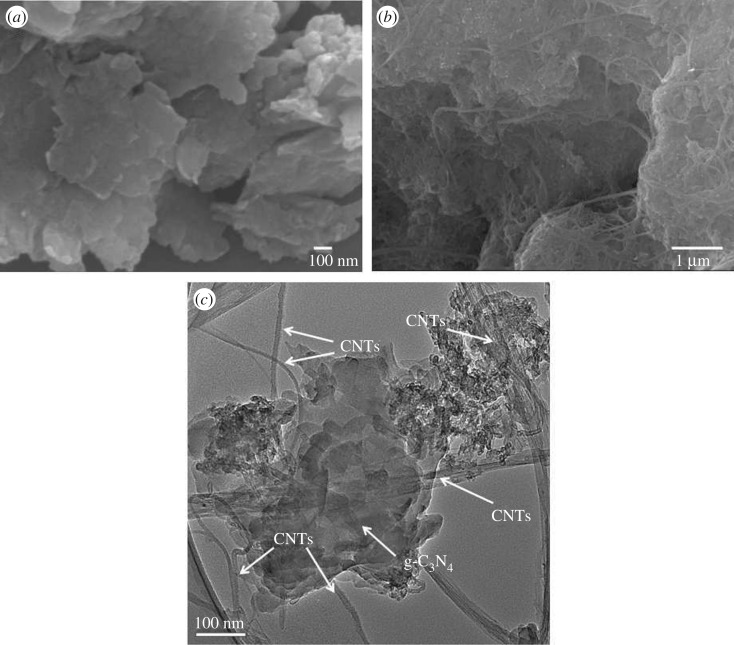
SEM images of the as-prepared samples: (a) g-C3N4, (b) C60/CNTs/g-C3N4, (c) TEM image of the C60/CNTs/g-C3N4.